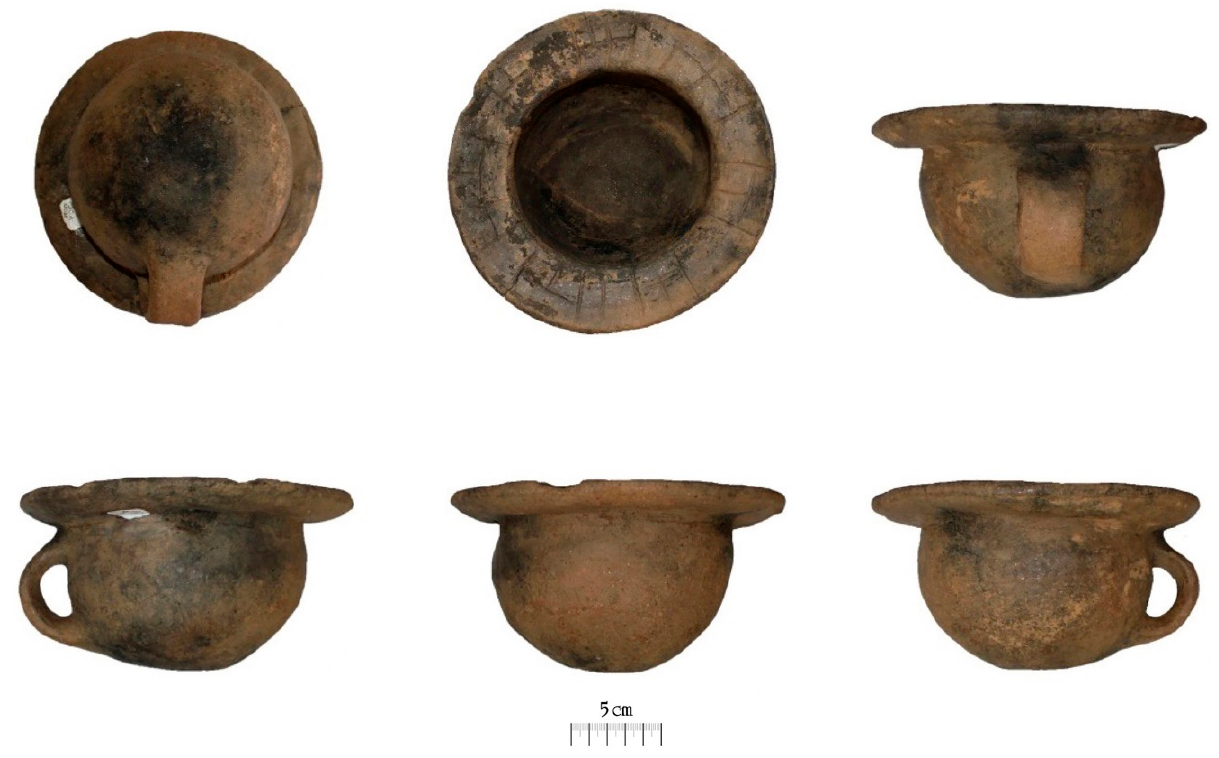
Figure 3. Multiple perspectives of the vessel.